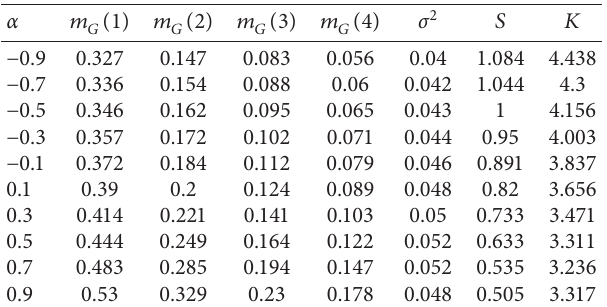
Table 4: Values of moment measures of the NTMW distribution for c � 0 . 5 and k � 2 and different values for α